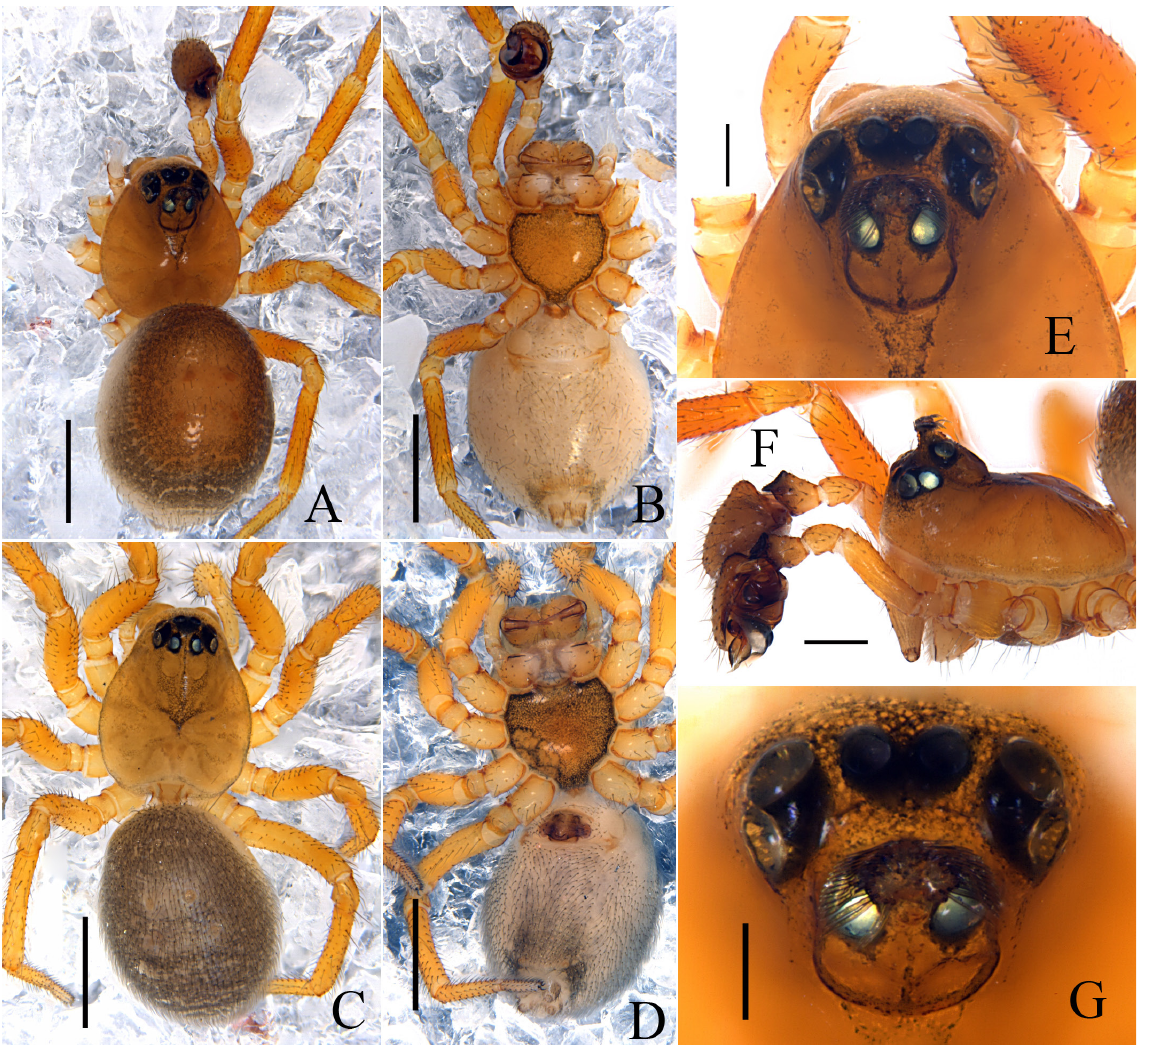
Fig. 5. Yuelushannus alatus sp. nov., male, holotype HNDWS–18–04~01 (A–B, E–F) and female allotype HNDWS–18–04~02 (C–D, G). A , C . Habitus, dorsal view. B , D . Habitus, ventral view. E , G . Cephalothorax, dorsal view. F . Habitus, lateral view. Scale bars: A–D = 0.5 mm; E, G = 0.1 mm; F = 0.2